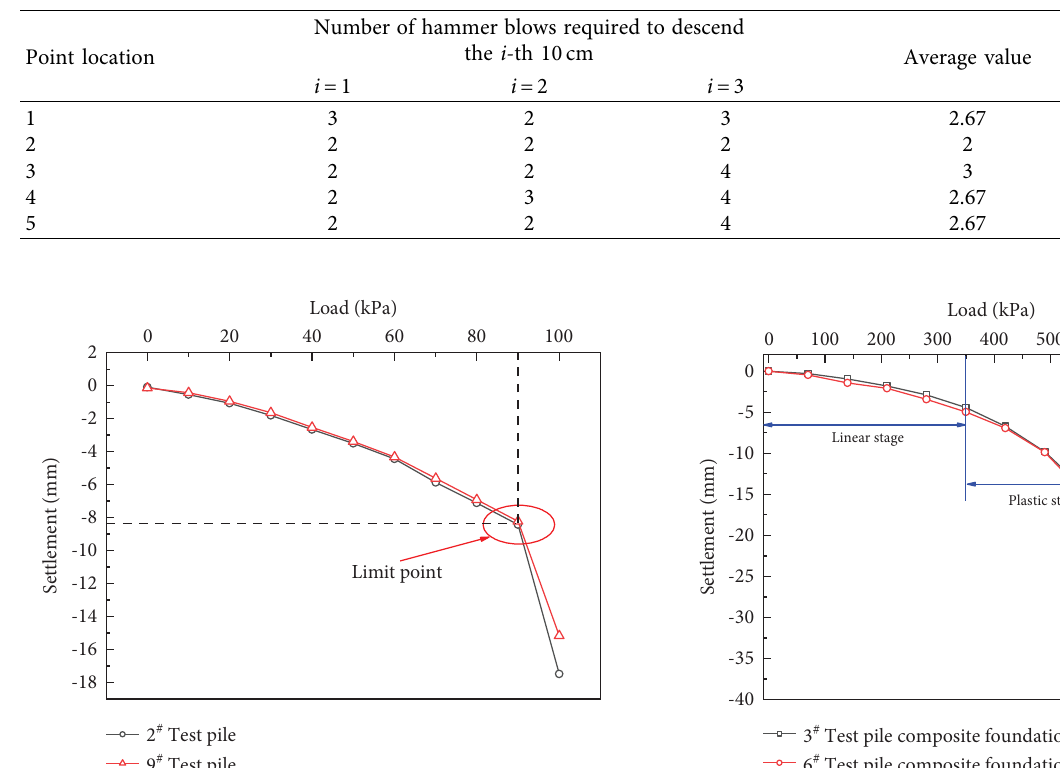
Table 4: Heavy-duty touch record table.